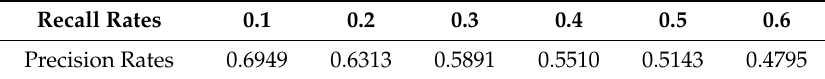
Table 2. Retrieval precision on the database Corel-1k with { λ 1 = 0, λ 2 = 1 } . Recall